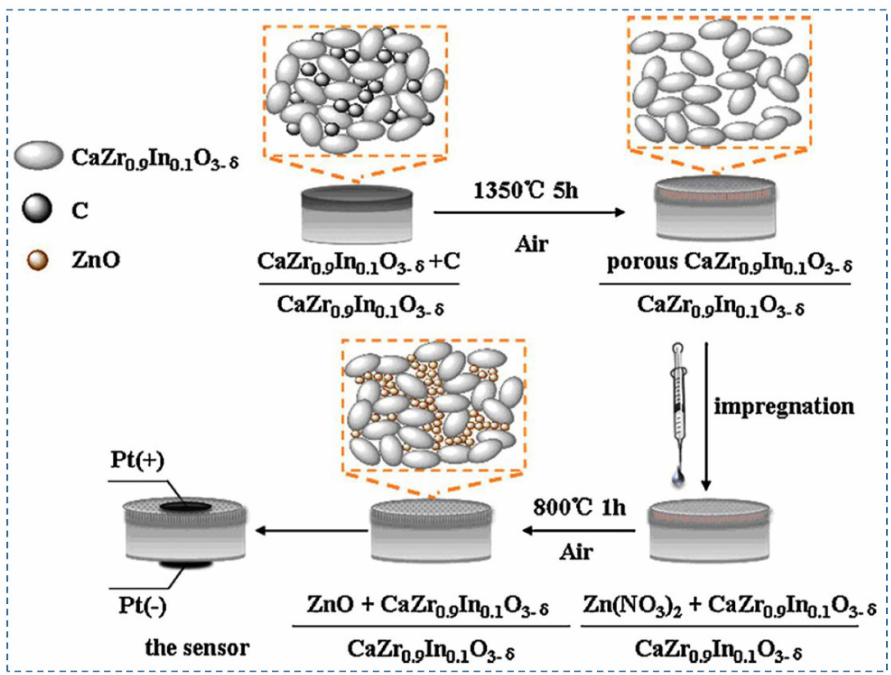
Figure 10. Chemical composition of materials and the schematic of the fabrication process of the hydrogen sensor. Reprinted with permission from Ref. [83]. Copyright 2012